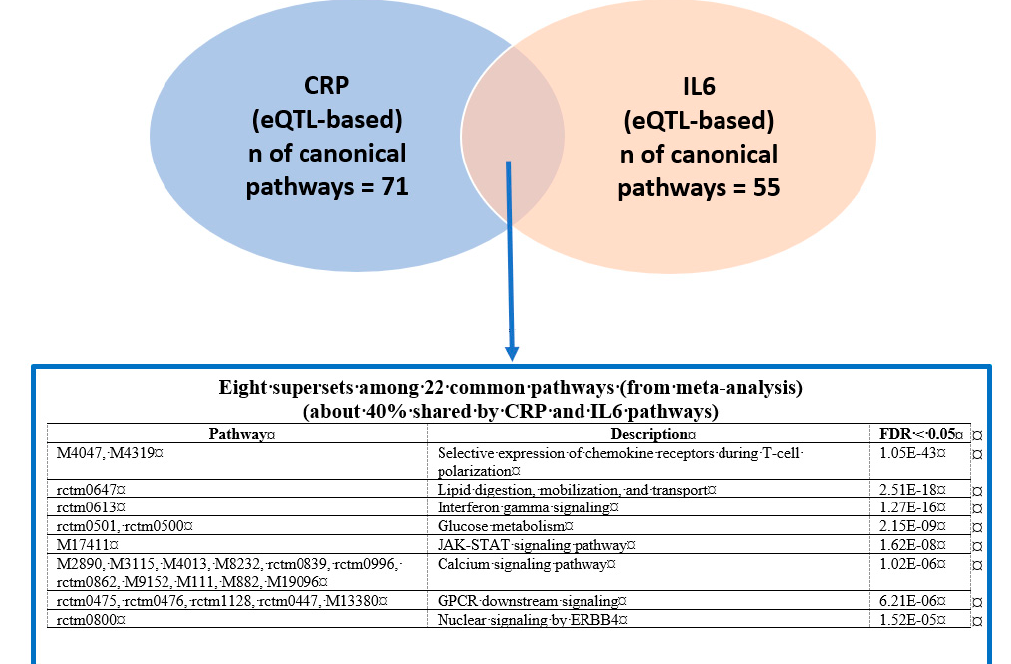
Figure 2. Comparison of significant pathways (false discovery rate [FDR] < 0.05) between C-reactive protein (CRP) and interleukin-6 (IL6) phenotypes (CRP/IL6, expression quantitative trait loci [eQTL]–based mapping; GPCR, G protein– coupled receptor; JAK-STAT, Janus kinase-signal transducer and activator of